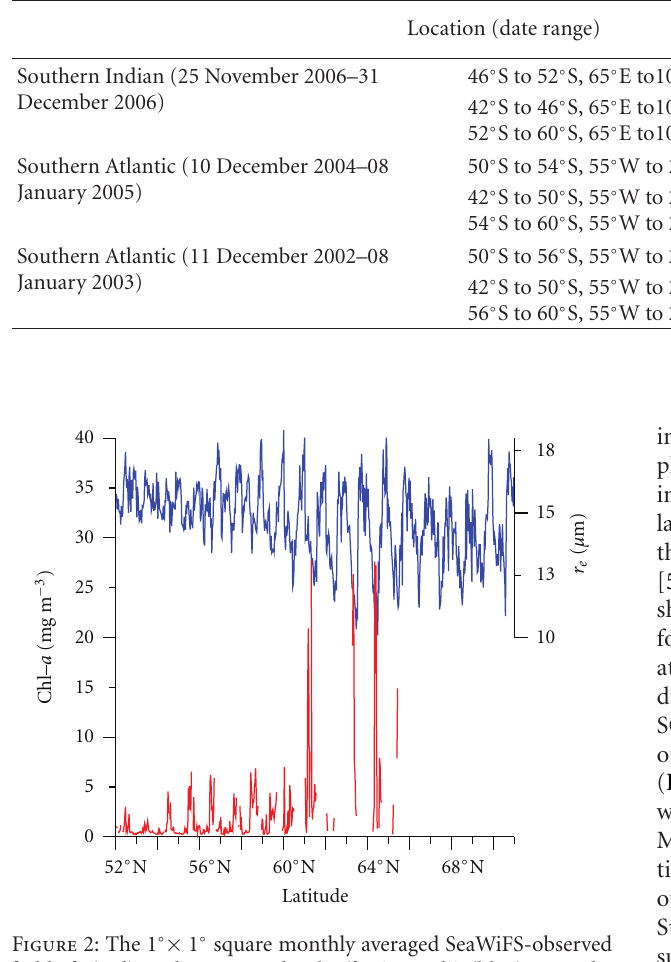
Table 3: Correlations of [Chl- a ] and r e for di ff erent events of Figure 3.